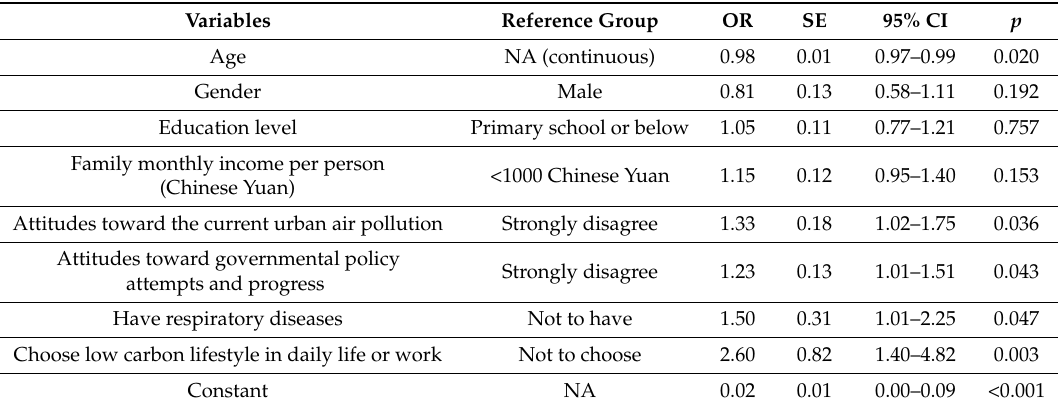
Table 5. Multivariable logistic regression analysis for the significant predictors of respondents’ perceptions on the health co-benefits in relation to GHG